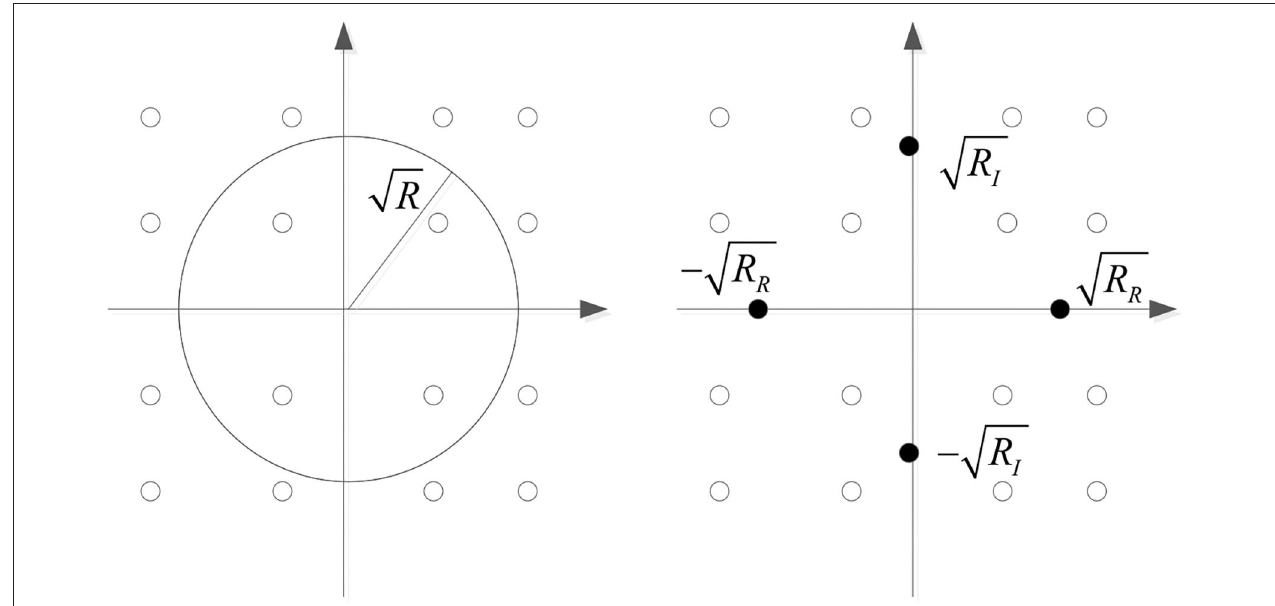
FIGURE 1 | Error signal track of CMA and